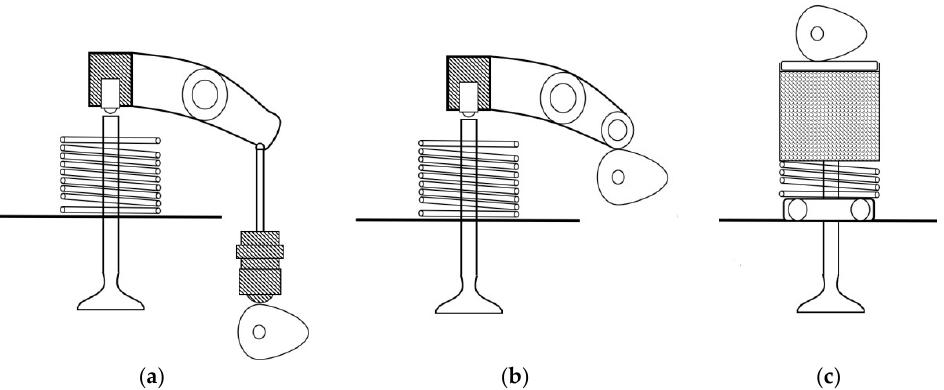
Figure 1. Types of Camshaft Arrangements: ( a ) down-mounted camshaft, ( b ) middle-mounted camshaft; ( c ) up-mounted camshaft.